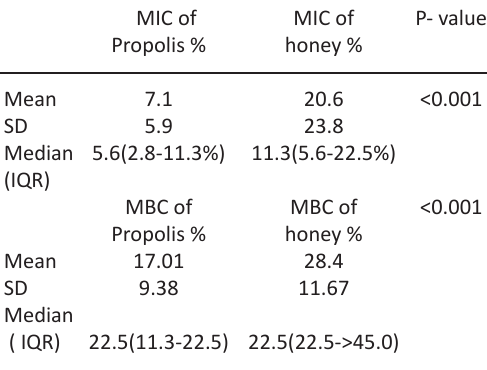
Table 4. Result of the Minimum inhibitory